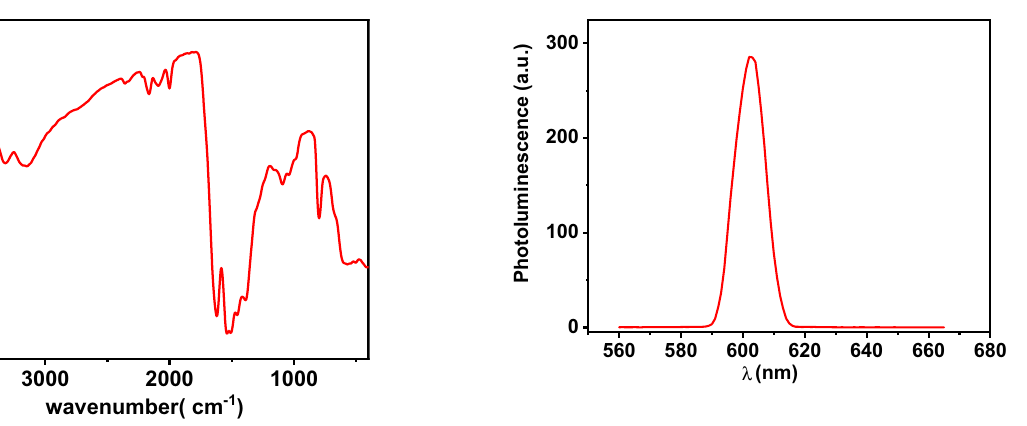
Fig. 7 Spectral dependence of PL of prepared